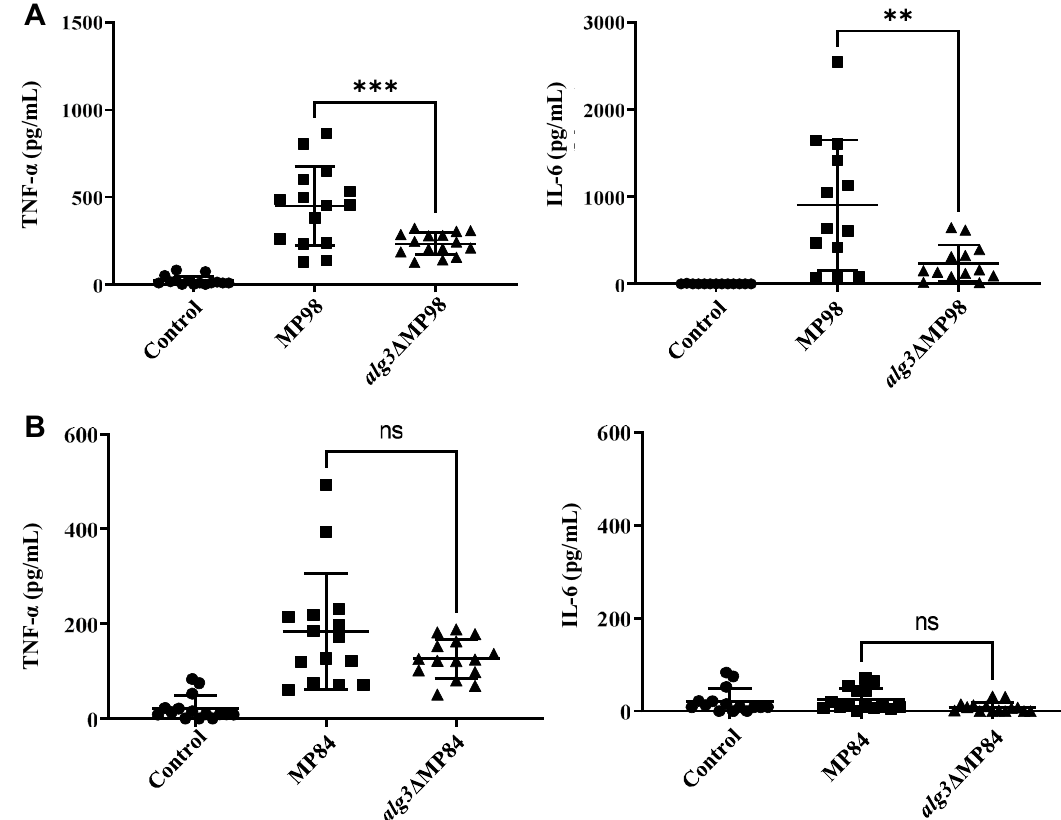
Figure 4. Analysis of the induced cytokine secretion from BMDCs by interaction with MP98 and MP84. After the co-incubation of BMDCs with purified MPs for 24 h, the secreted cytokines in the culture supernatants of BMDCs were examined with a bead-based immunoassay. ( A ) Secreted cytokines after co-incubation with MP98 and alg3 ΔMP98. ( B ) Secreted cytokines from BMDCs after co-incubation with MP84 and alg3 ΔMP84. Control is only host cells without incubation with MPs. Significant differences were determined through one-way ANOVA (** P ≤ 0.01; *** P ≤ 0.001, ns P >